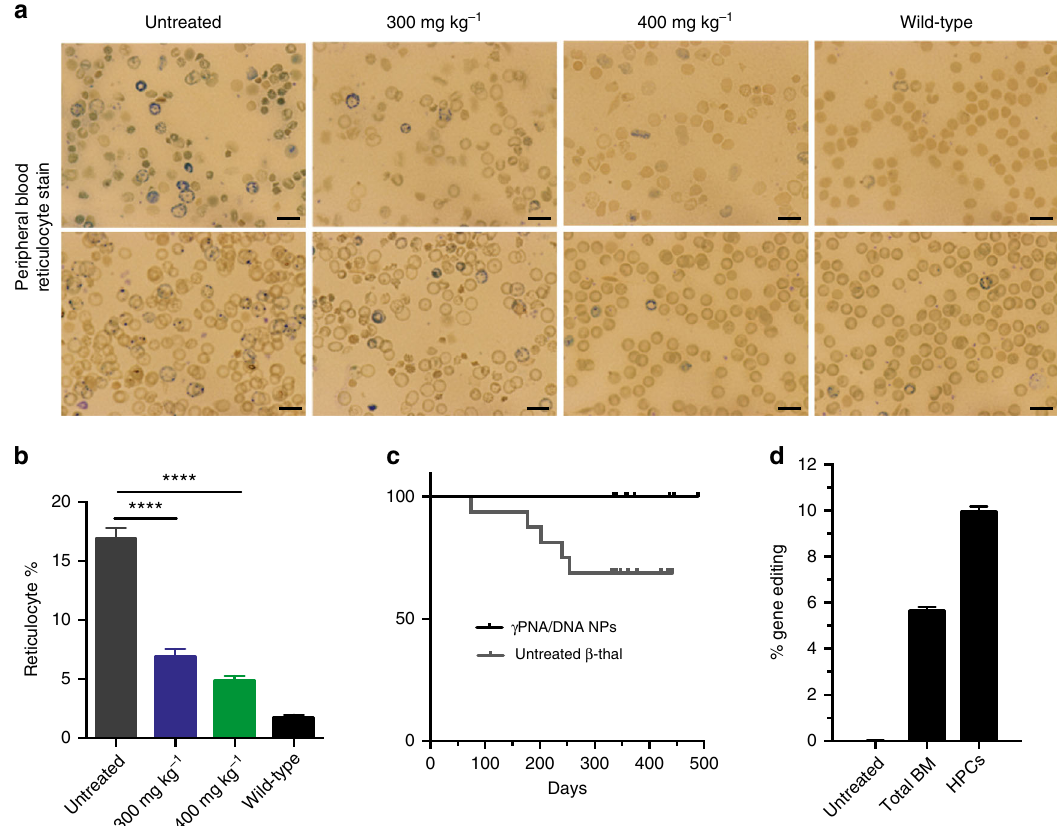
Fig. 4 Additional evidence for correction of anemia and disease phenotype in thalassemic mice after in utero γ tcPNA/DNA nanoparticle (NP) delivery. a , b Reticulotye ( a ) stains (blue) and ( b ) percentage of total red blood cells (RBCs) of Hbb th-4 /Hbb + mice 10 weeks after E15.5 intravenous (IV) γ tcPNA/DNA NP treatment compared to untreated Hbb th-4 /Hbb + and wild-type B6 mice, ( n = 6 for all groups), the data are mean ± s.e.m., statistical analysis by two- way ANOVA, **** P < 0.0001. Scale bars = 10 μ m. c Survival of Hbb th-4 /Hbb + thalassemic mice treated in utero on day E15.5 by IV injection of γ tcPNA/ DNA NPs versus untreated age-matched controls ( n = 16 for both groups), with statistical analysis by Log-rank Mantel – Cox test, p = 0.02. d Droplet digital PCR (ddPCR) quanti fi cation of gene editing in genomic DNA from total bone marrow and isolated hematopoietic progenitor cells (HPCs) collected from mice 15 weeks post-treatment (E15.5 by IV injection of γ tcPNA/DNA NPs), compared to untreated Hbb th-4 /Hbb + controls, ( n = 3), data are mean ±